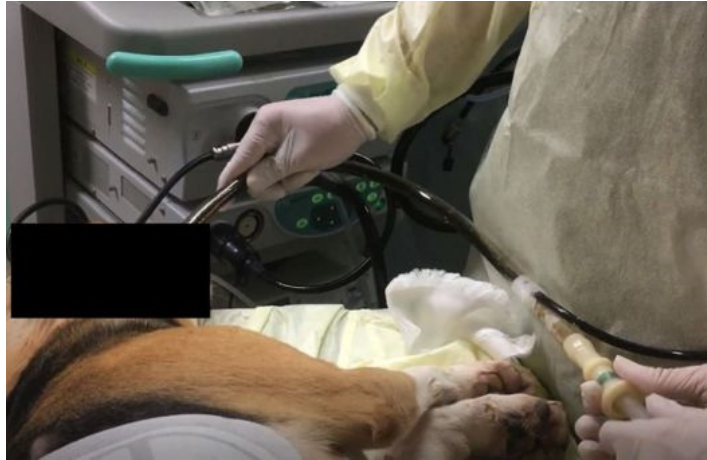
Figure 6. Outside condition during suction.